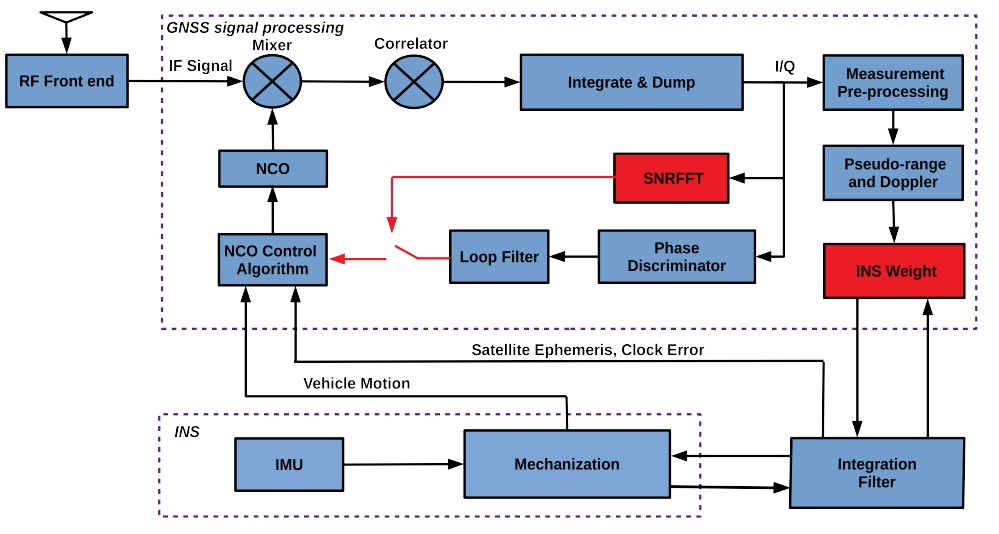
Figure 1. GNSS/INS deeply-coupled software defined receiver